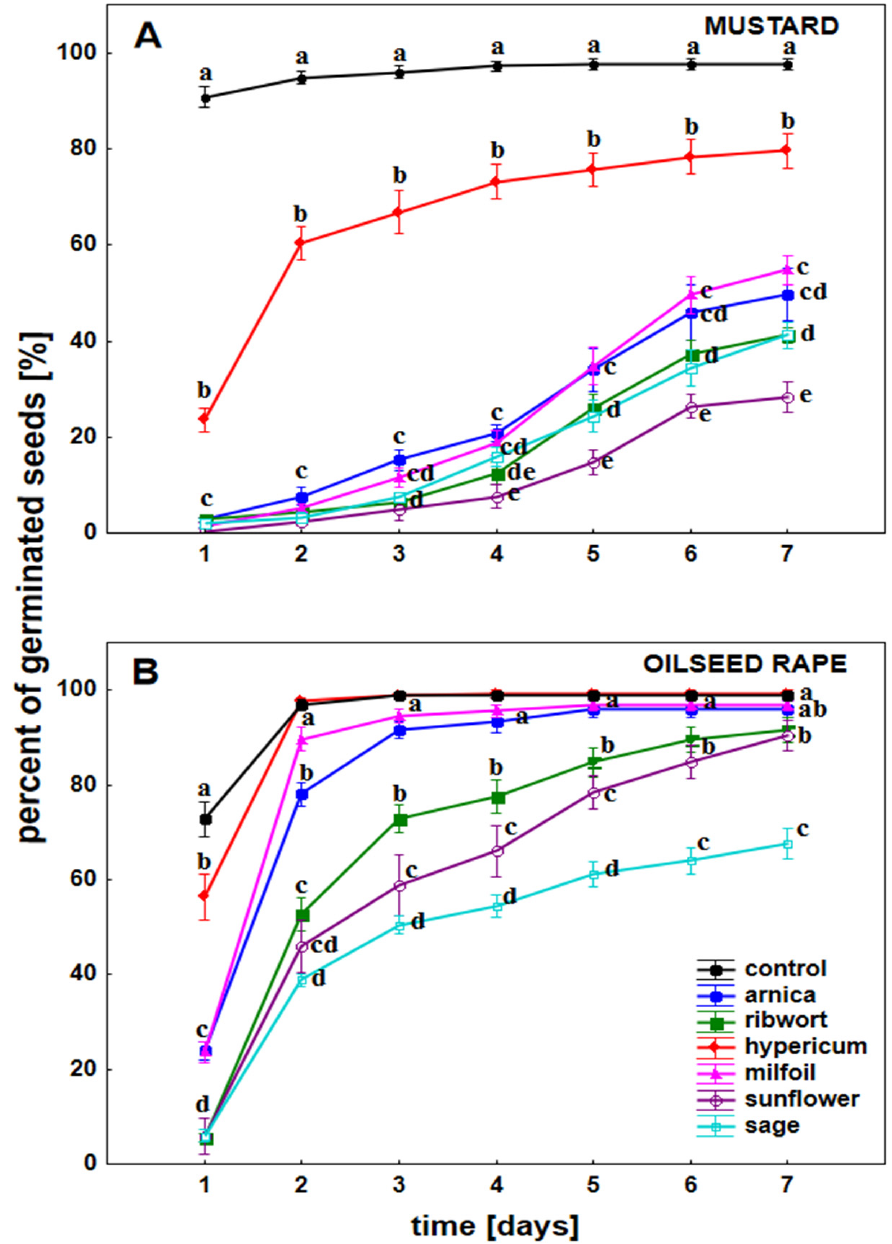
Figure 1. Percentage of the seeds of white mustard ( A ) and oilseed rape ( B ) that had been germinated on the 10% ( w / v ) extracts from arnica (blue line), ribwort (green line), hypericum (red line), milfoil (pink line), sunflower (violet line), sage (light blue line) and water—control (black line). The mean values ± SD indicated by the same letters did not differ significantly at p ≤ 0.05 according to Duncan’s test (within the day of germination), n = 10.